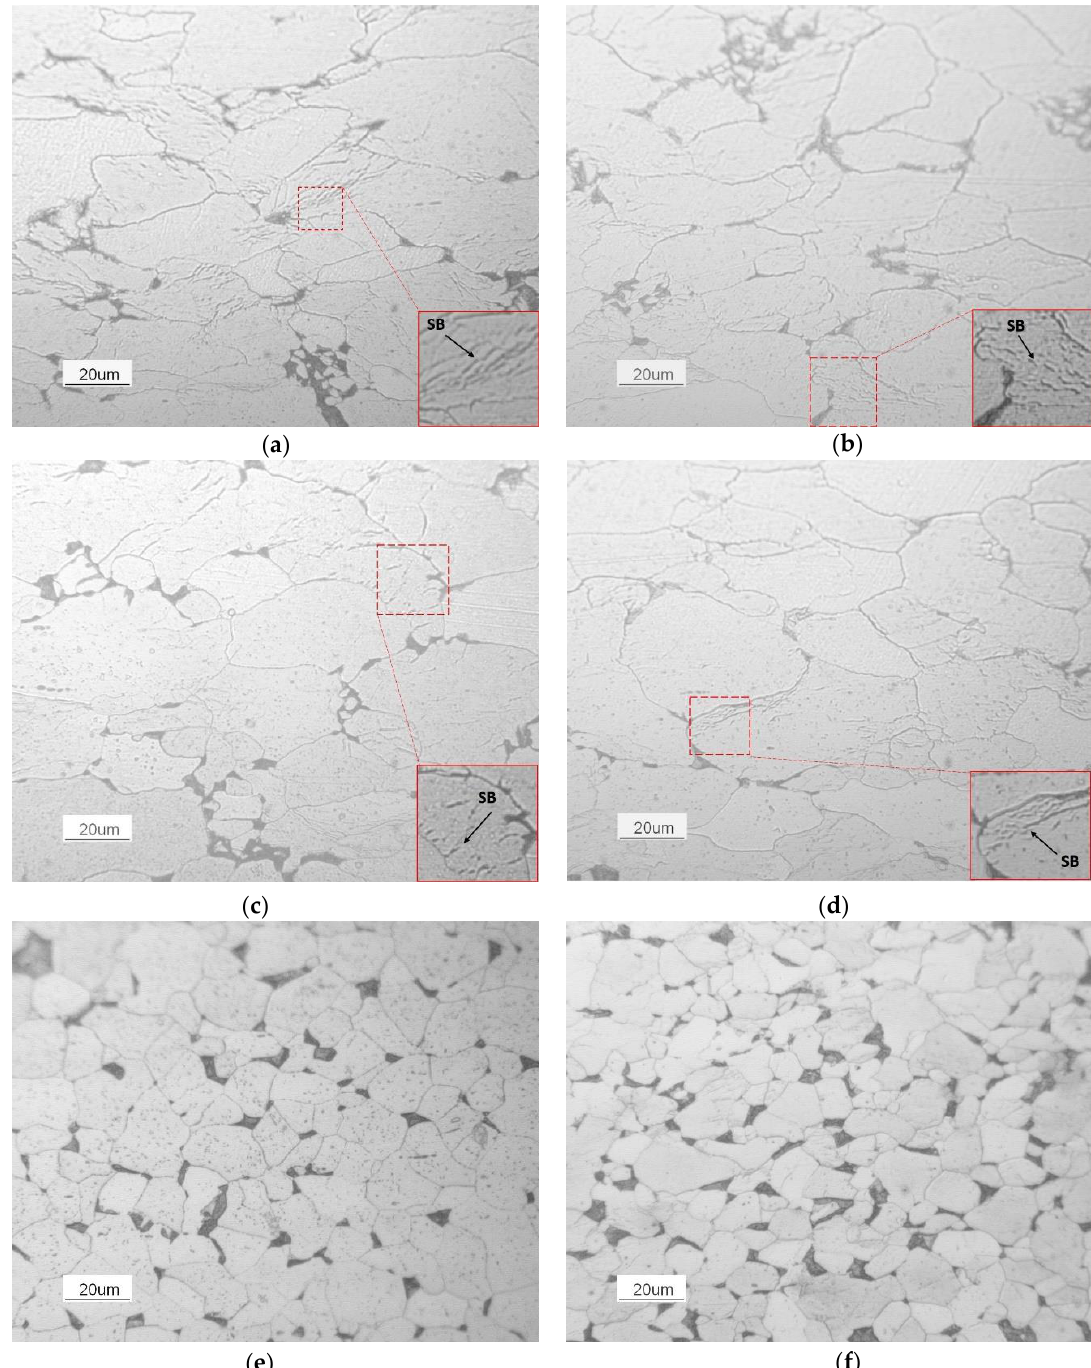
Figure 2. Optical micrographs of LCHB steels warm rolled at ( a ) 790 ◦ C, 1000:1000 rpm, ( b ) 790 ◦ C, 1500:1000 rpm, ( c ) 830 ◦ C, 1000:1000 rpm, ( d ) 830 ◦ C, 1500:1000 rpm, ( e ) 870 ◦ C, 1000:1000 rpm, ( f ) 870 ◦ C, 1500:1000